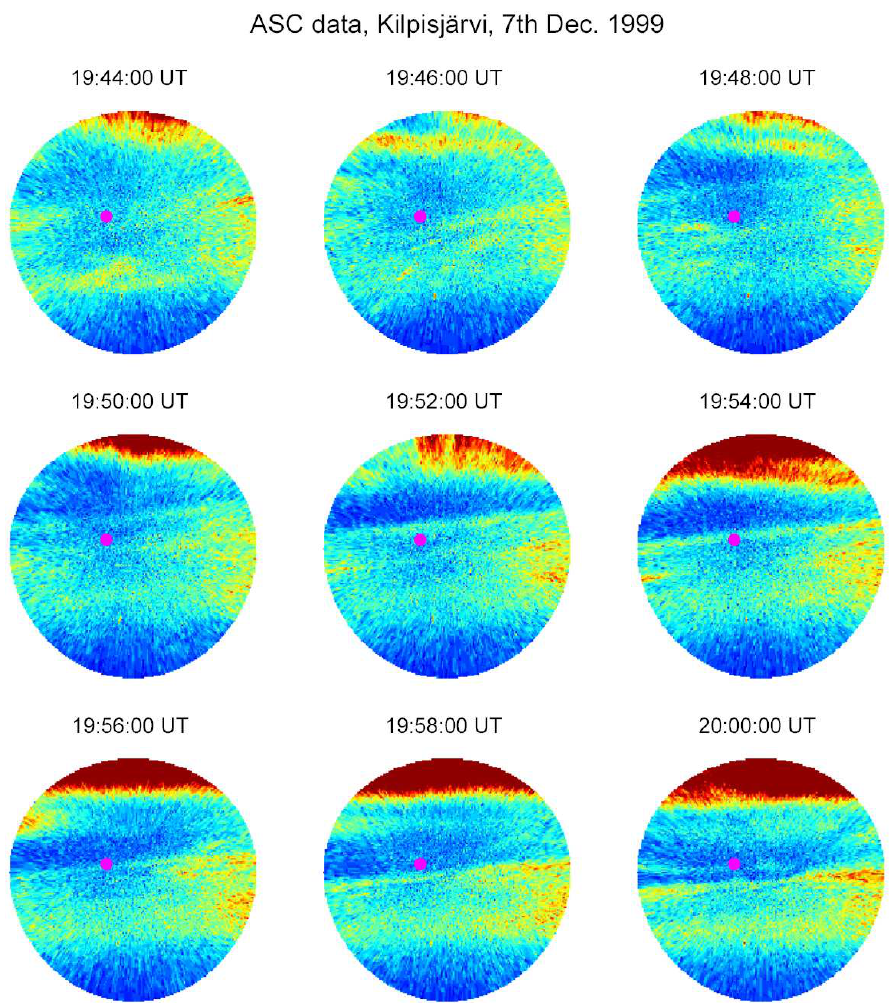
Fig. 1. Kilpisj¨arvi ASC data from nine selected times from Event 1 on 7 December 1999. The ASC images are shown in false colour, mapped to the longitude-latitude grid, assuming the height of 100km for the structures. The auroral intensities are arbitrary and scaled from the original 8-bit gray scale image. The studied arc can be seen from 19:48UT onward, on the poleward side of the diffuse aurora. It drifts equatorward and reaches the EISCAT beam location (marked with magenta dot) at 19:54UT. At 20:00UT the second weak arc can be seen in the location of